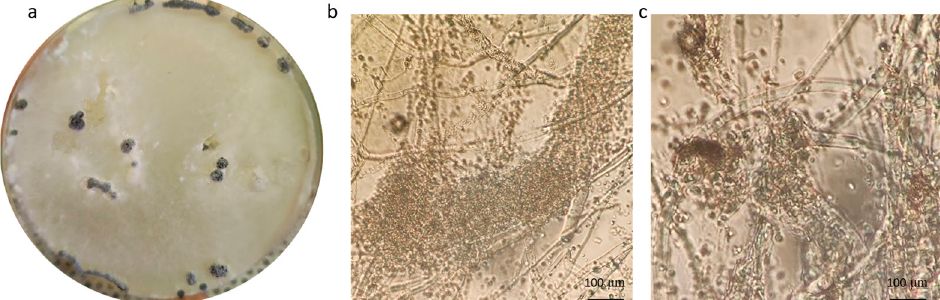
Figure 5. S. sclerotiorum CREA OF 1113.1 morphological features: ( a ) colony morphology on PDA and sclerotia after 15 days of growth; ( b ) ascopores and apothecium; ( c ) sclerotium development.